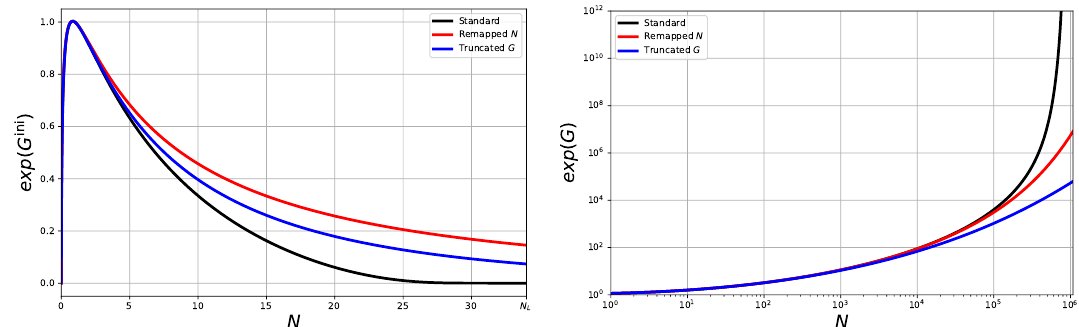
Figure 1 . Different ways for dealing with the Landau pole in the NNLL Sudakov factors for the PFF (left) and the coefficient function (right). The PFF Sudakov factor is evaluated for µ while the one for the coefficient function is shown for µ Sudakov factor without any regularisation of the Landau pole (black), with N remapped (red) and with a truncated exponent